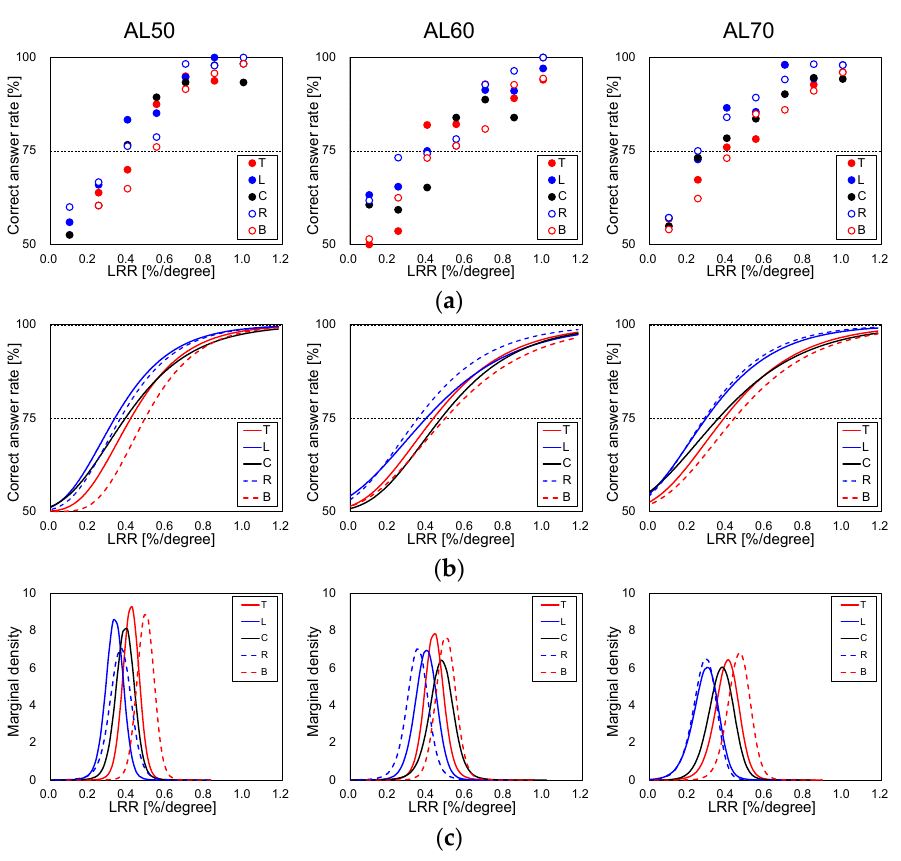
Figure 8. The results of ( a ) the average correct answer rate, ( b ) the estimated psychometric function, and ( c ) the posterior distribution for LRR TH of AL50 (left), AL60 (center), and AL70 (right) conditions.